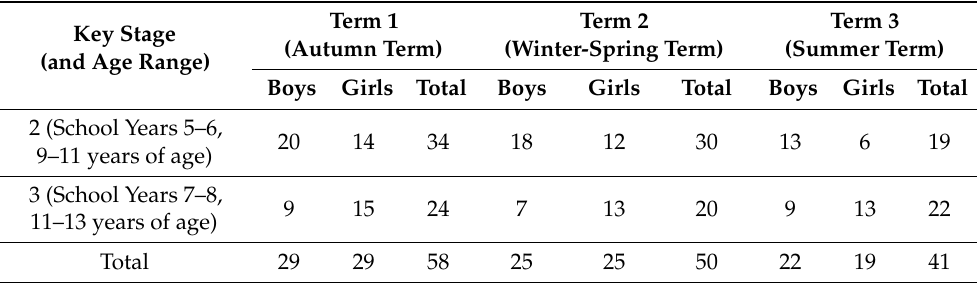
Table 1. Breakdown of the children each school term according to the school key stage (key stage 2 = 9–11 years; key stage 3 = 11–13 years) and